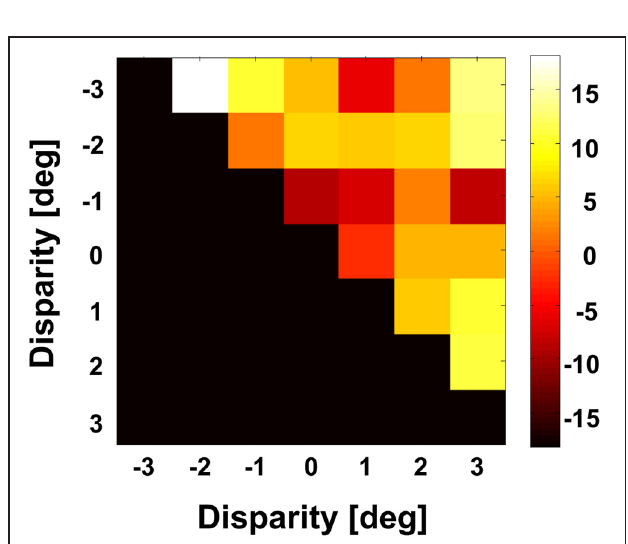
FIGURE 7 | Average angular differences in directional tuning. The scatter plot shows for each neuron the average angular difference between preferred directions (PDs) of visual motion at different disparities. The red symbol indicates the value from the neuron whose